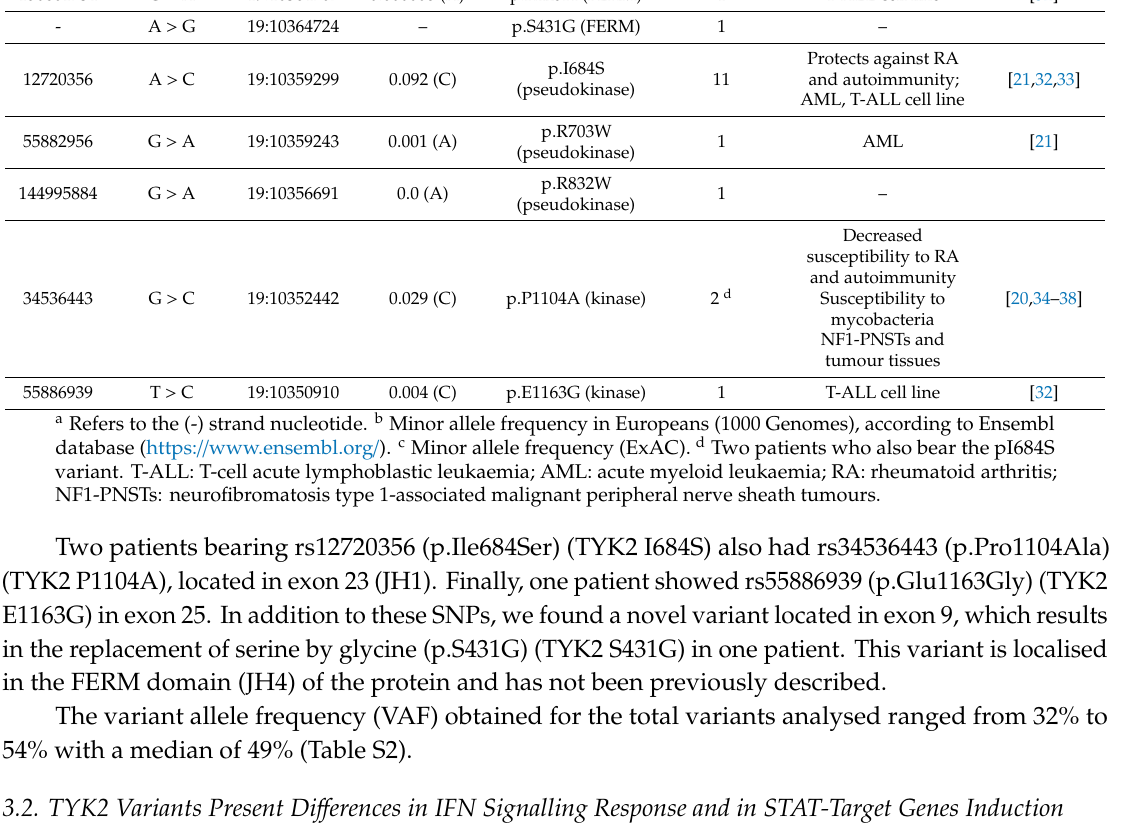
Table 1. Disease-associated non-synonymous TYK2 variants.